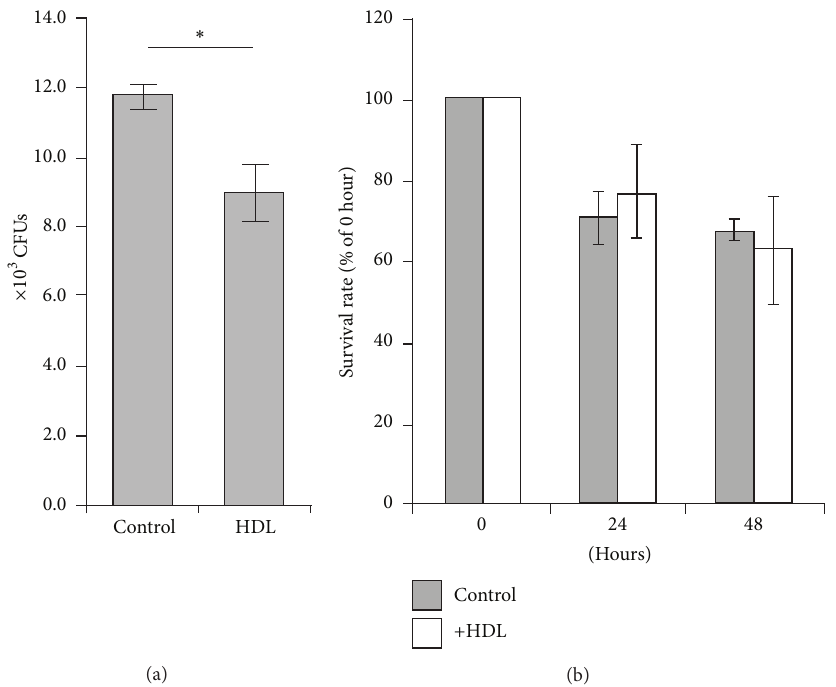
Figure 5: Effects of HDL on the viability of M. avium engulfed by THP-1 macrophages. (a) THP-1 macrophages (10 6 /well) were infected with live M. avium in the presence or absence (control) of HDL (50 𝜇 g protein/mL) for 24 h. M. avium was recovered from lysed THP-1 macrophages for an assay of colony-forming units (CFUs; 3 weeks culture). (b) A part of infected THP-1 macrophages was further cultured for 24 and 48h in a fresh medium. CFUs were also determined as described above. The data were indicated as the percentages against CFUs obtained without further cultivation. The values were indicated by mean ± SEM ( 𝑛 = 3 , ∗ 𝑃 < 0.05